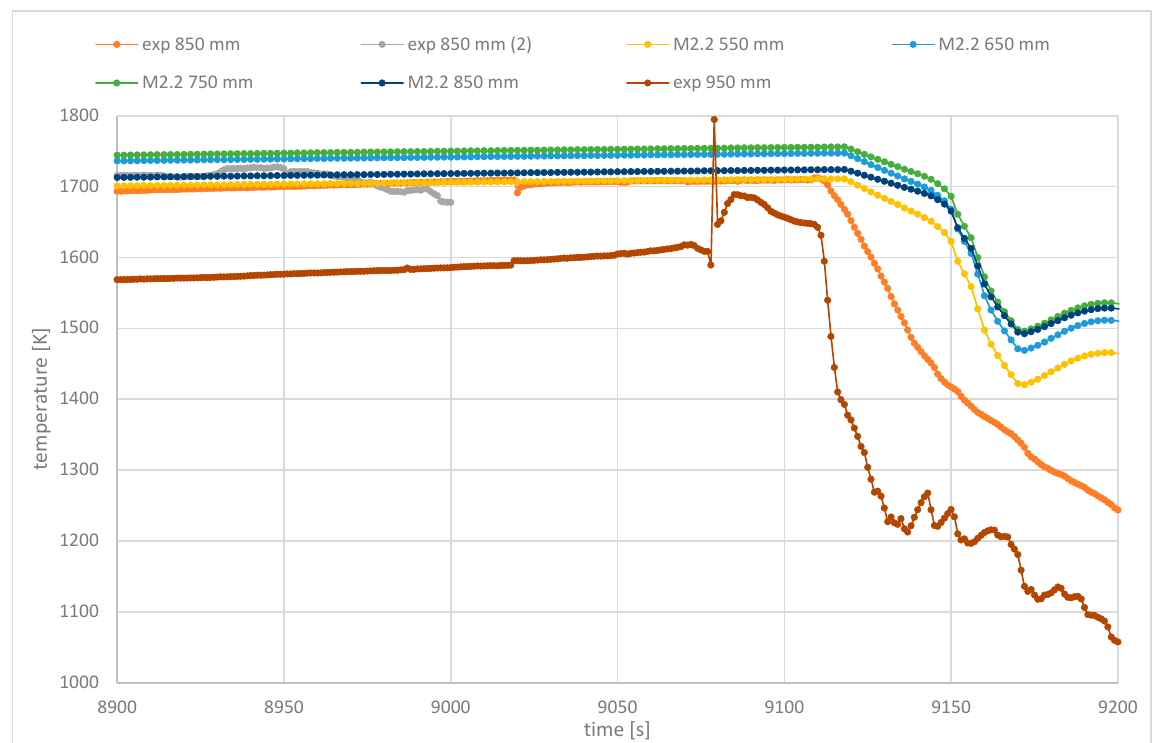
Figure 13. Temperatures measured in the heated part of the bundle, detail view 9000–9200 s (axial level, rod)